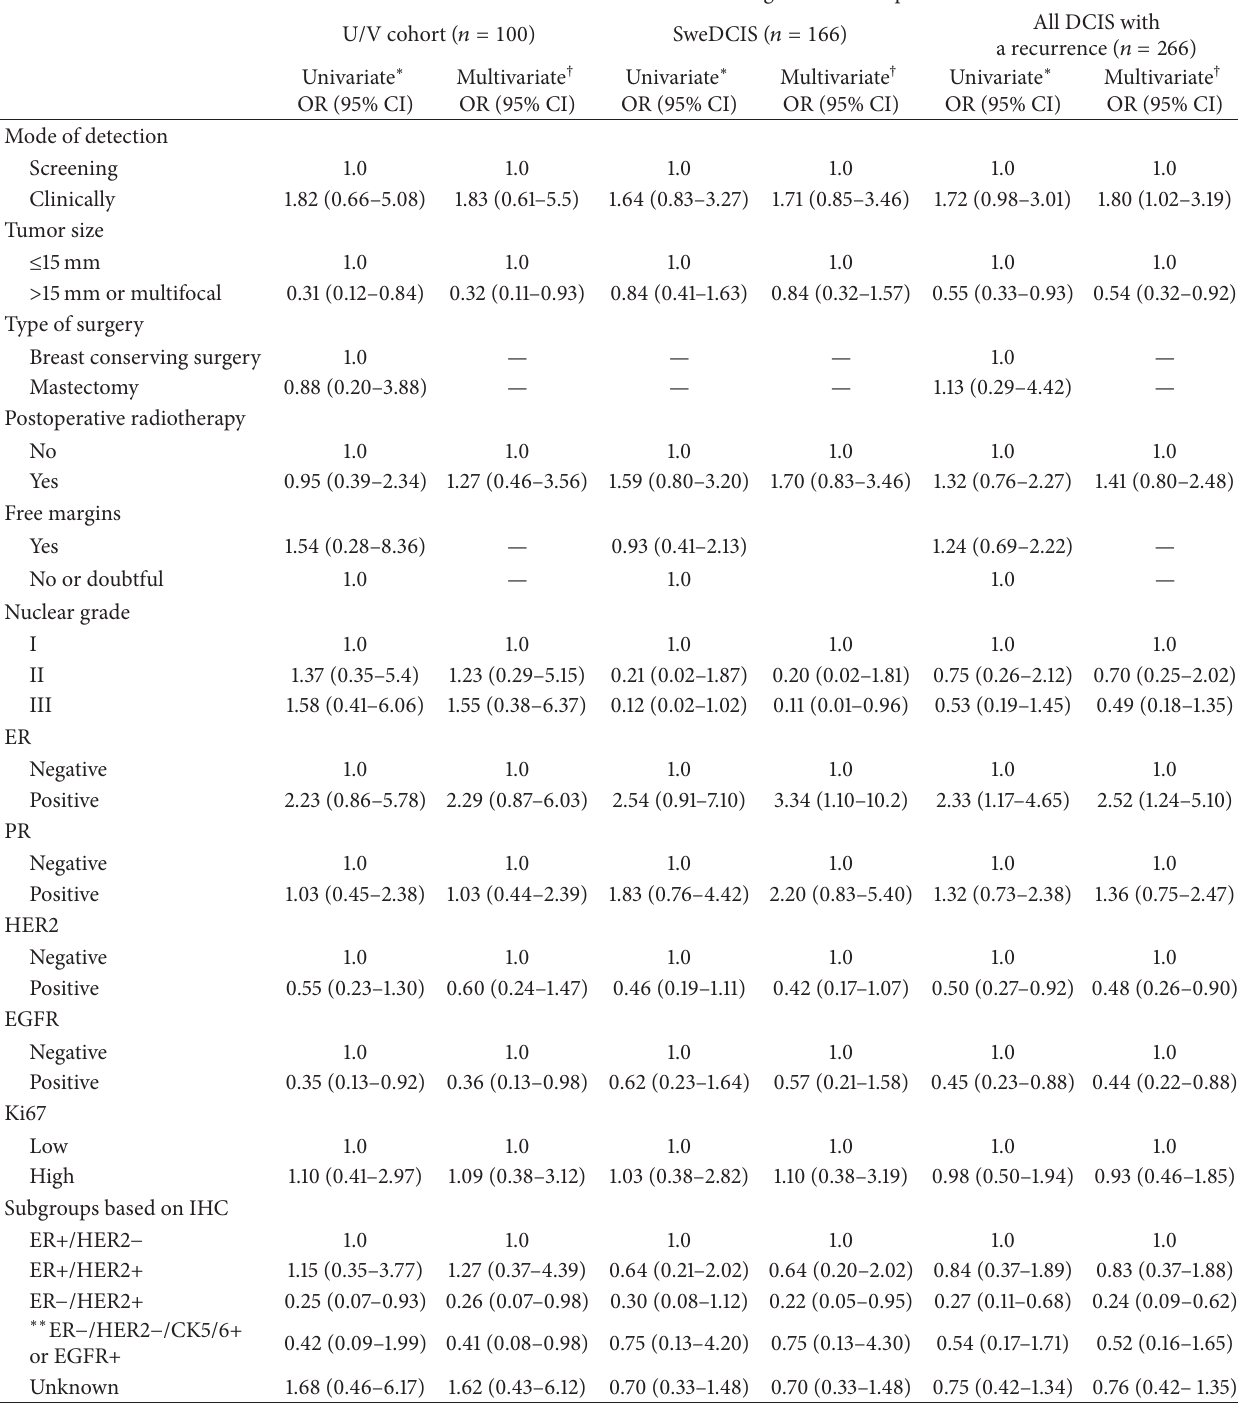
Table 3: Univariate and multivariate analysis of the associations between baseline clinical-, histopathological-, and molecular characteristics and the risk for a recurrence being invasive carcinoma compared to in situ carcinoma, among women with a primary DCIS and a known recurrence in the Uppsala/V¨aster˚as cohort, in the SweDCIS randomized study and in the two groups pooled together ( 𝑛 = 266 ). Risk of a recurrence after DCIS being invasive compared to a new in situ